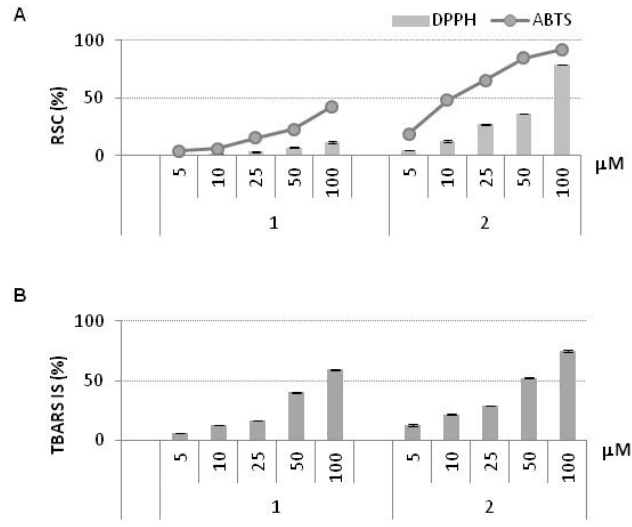
Figure 4. Antioxidant activity of PNA-CA dimers 1 and 2. ( A ) Radical Scavenging Capacity (RSC, %) towards DPPH • and ABTS •+ ( B ) TBARS Inhibition Synthesis (TBARS IS, %). Values, reported as percentage vs . a blank, are the mean value ± SD of measurements carried out on 3 samples (n = 3) analyzed three times.